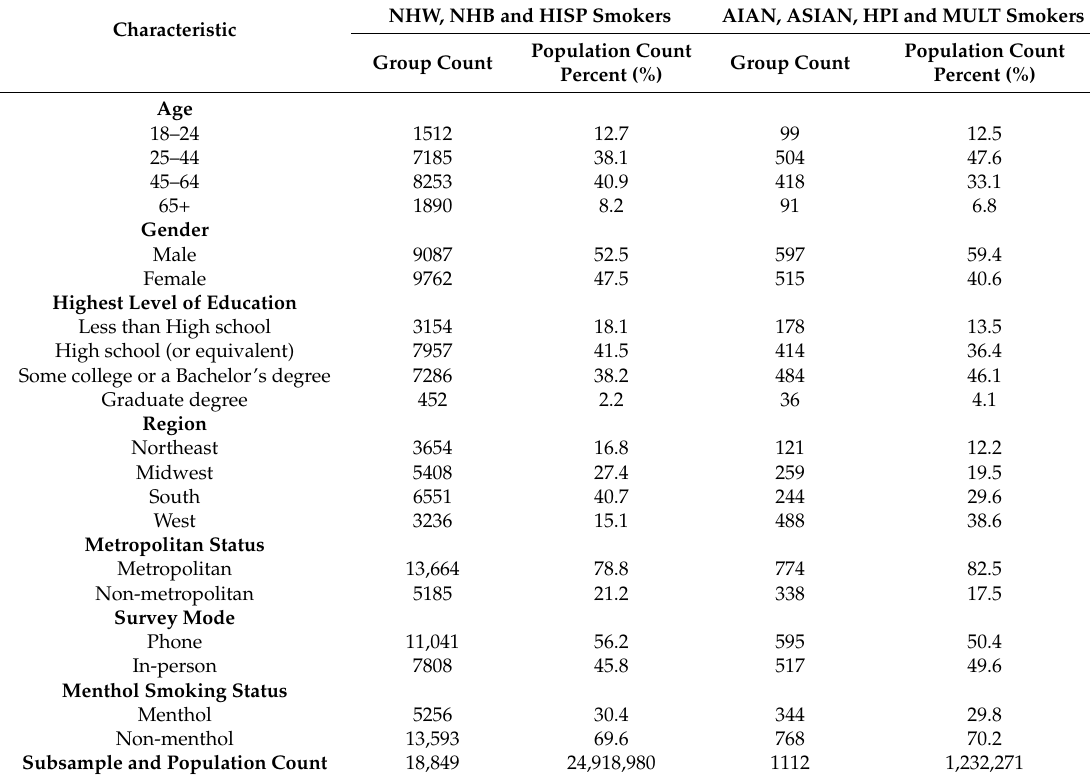
Table 1. Sample characteristics of the daily smokers for larger and smaller racial/ethnic